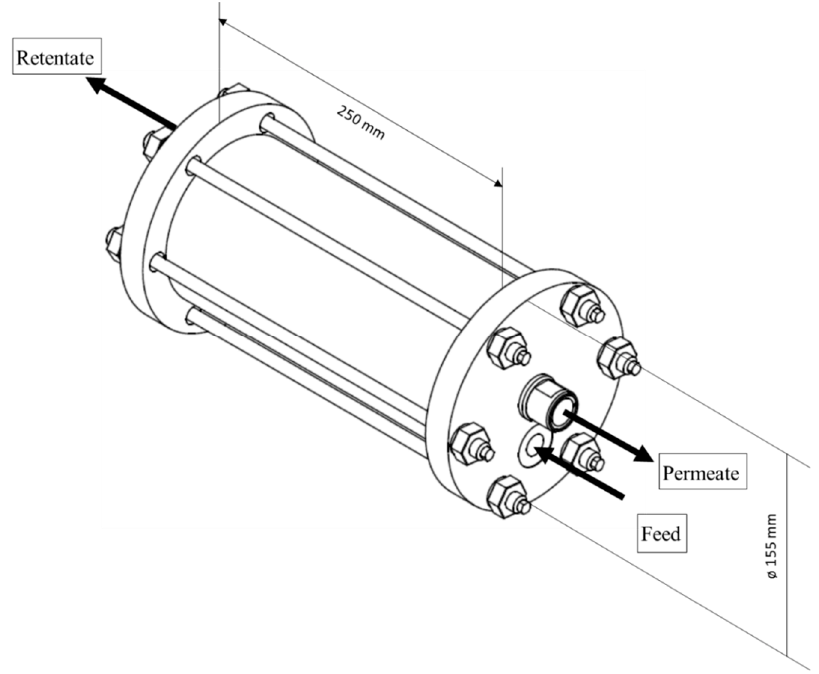
Figure 4. Schematic drawing of K100 envelope-type flat-sheet membrane module.